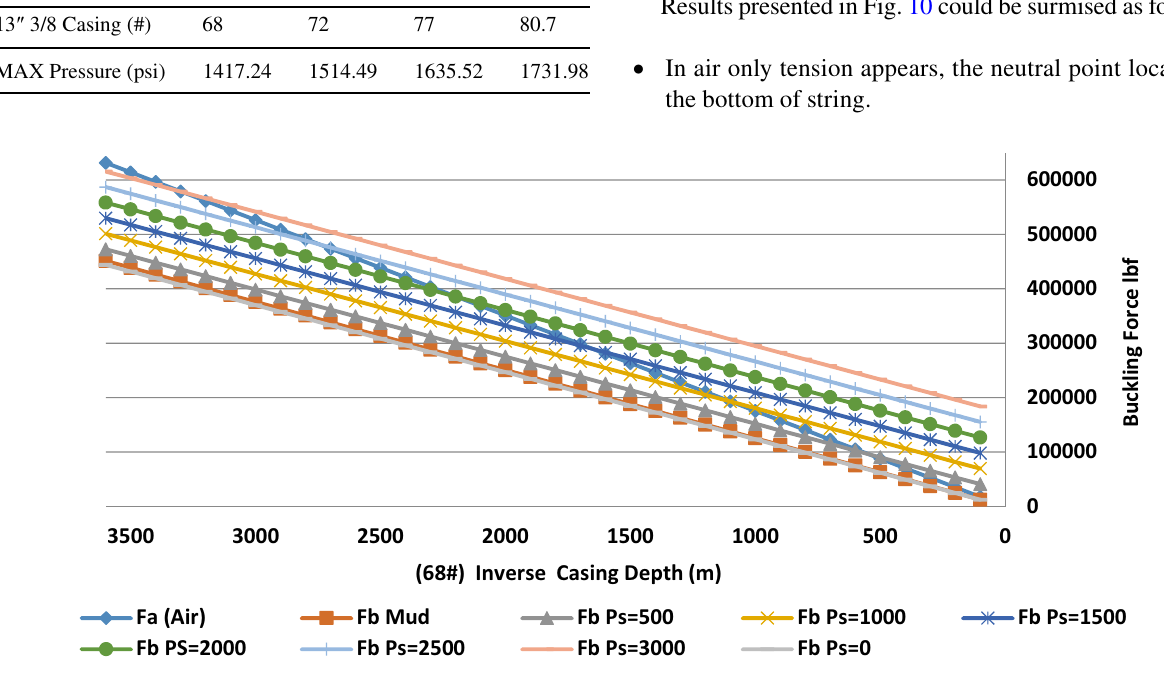
Table 4 Maximum allowable surface pressure for 13 ″ 3/8 cement